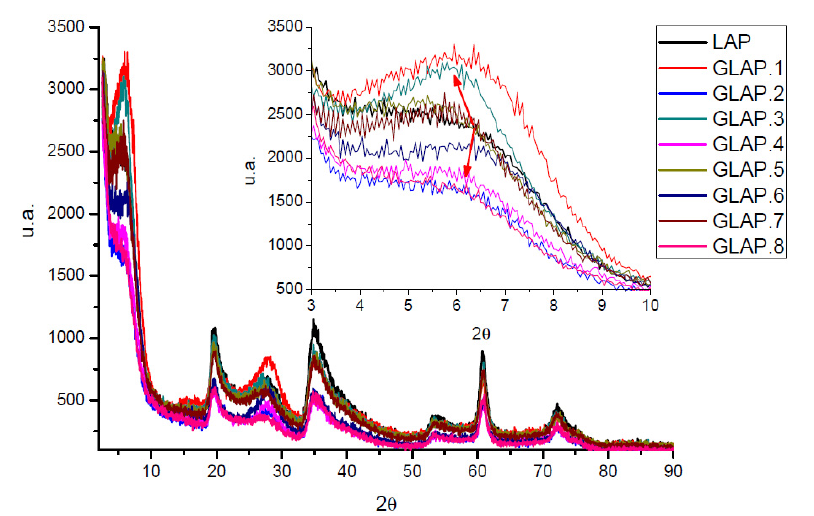
Figure 13. XRD patterns for the laponite (LAP), and the chlorophyll hybrid pigments [GLAP.1_8].